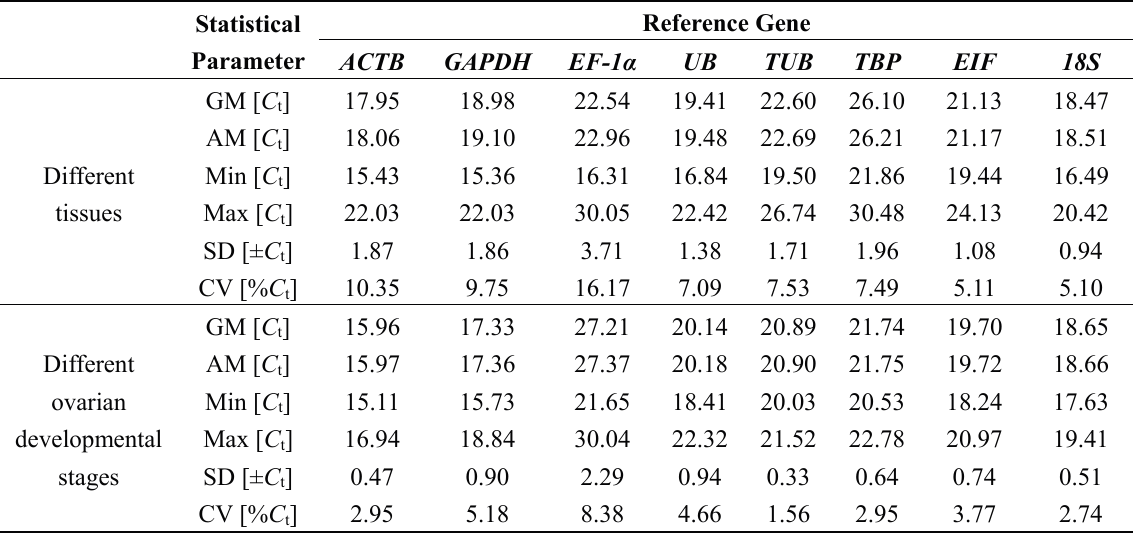
Figure 3. Expression stability of eight candidate reference genes calculated by NormFinder. The expression stability value (M; y -axis) is a measure of gene expression stability. ( A ) Expression stability of different tissues in P. clarkii ; ( B ) Expression stability of different ovarian developmental stages in P. clarkii. Table 3. Expression stability of candidate reference genes under different experimental conditions as calculated by